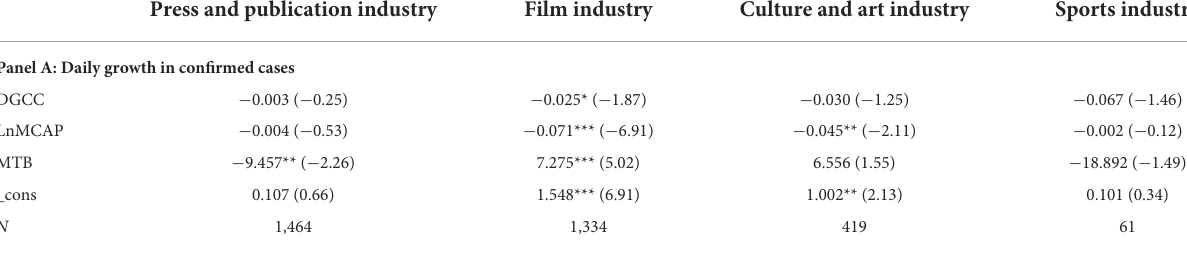
TABLE 4 Panel regression with specific sectors dummy